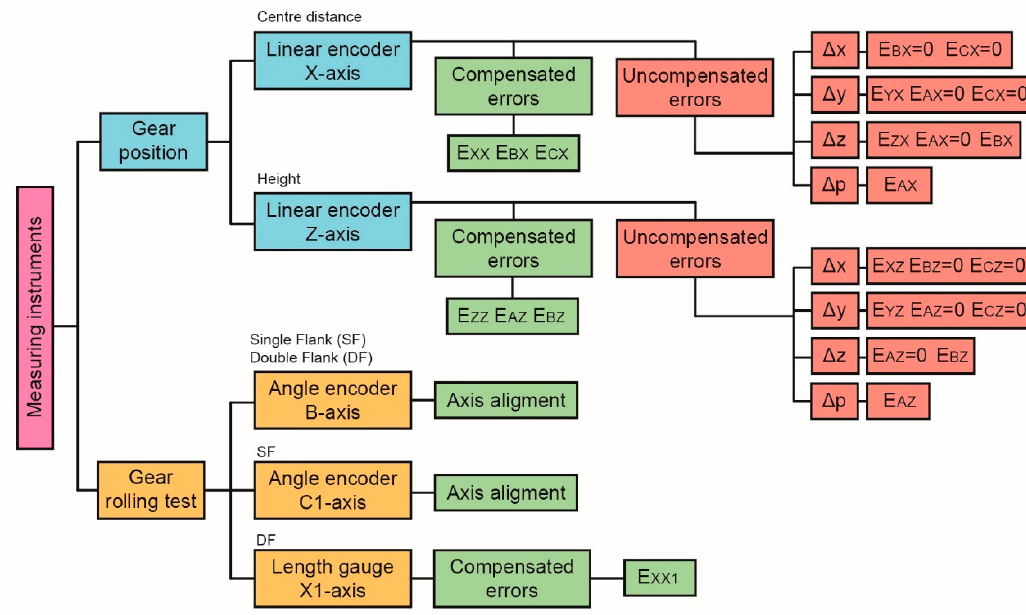
Figure 3. Measuring instruments calibration and evaluation procedure.